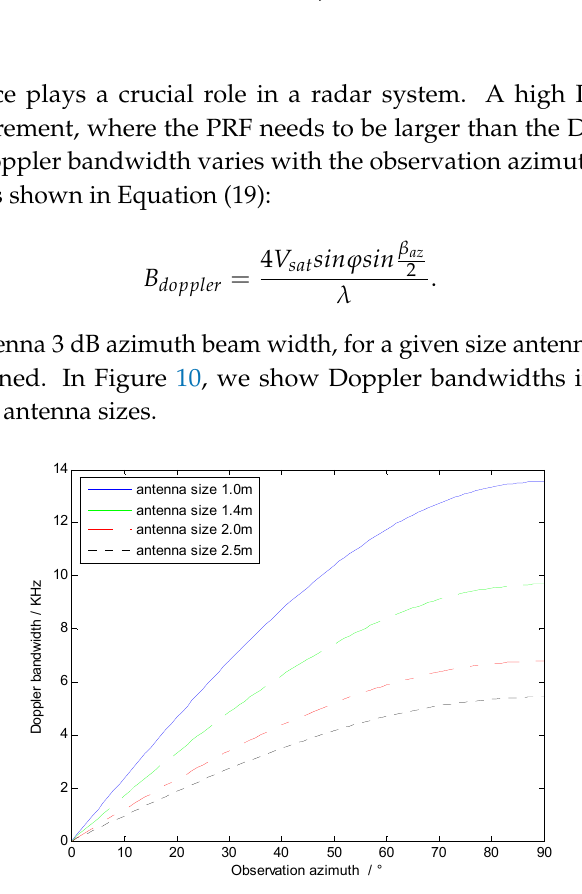
Figure 10. Doppler bandwidths in different observation azimuths with different antenna sizes.